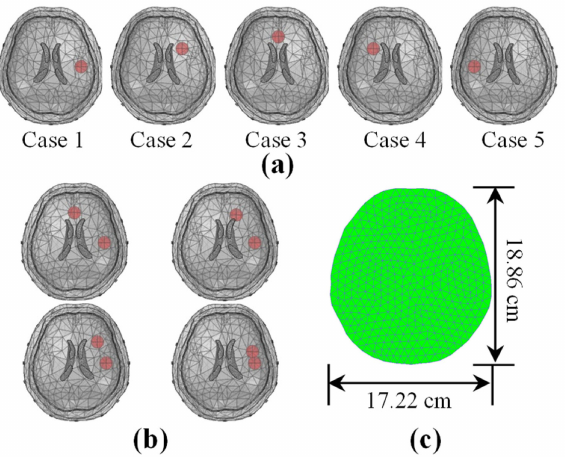
Figure 2. The model used in simulation experiments. ( a ) 5 mL spherical target at various locations in a 3D head model. ( b ) Two 5 mL spheres at distances of 7.07, 5.56, 3.83, and 1.95 cm, respectively. ( c ) Finite element model for the inverse